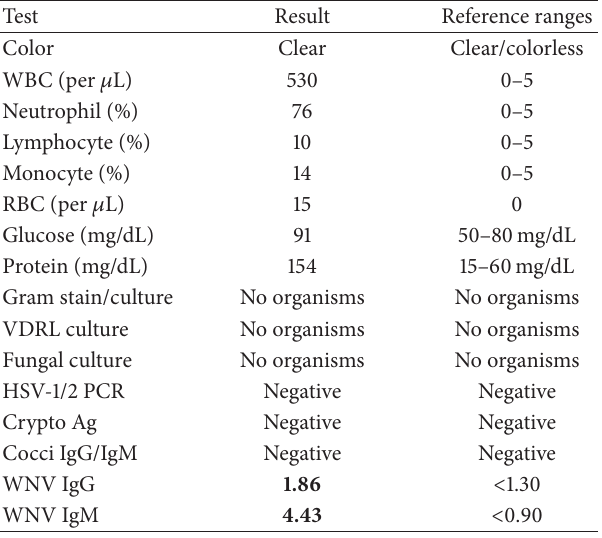
Table 1: Results of laboratory testing on the patient cerebrospinal